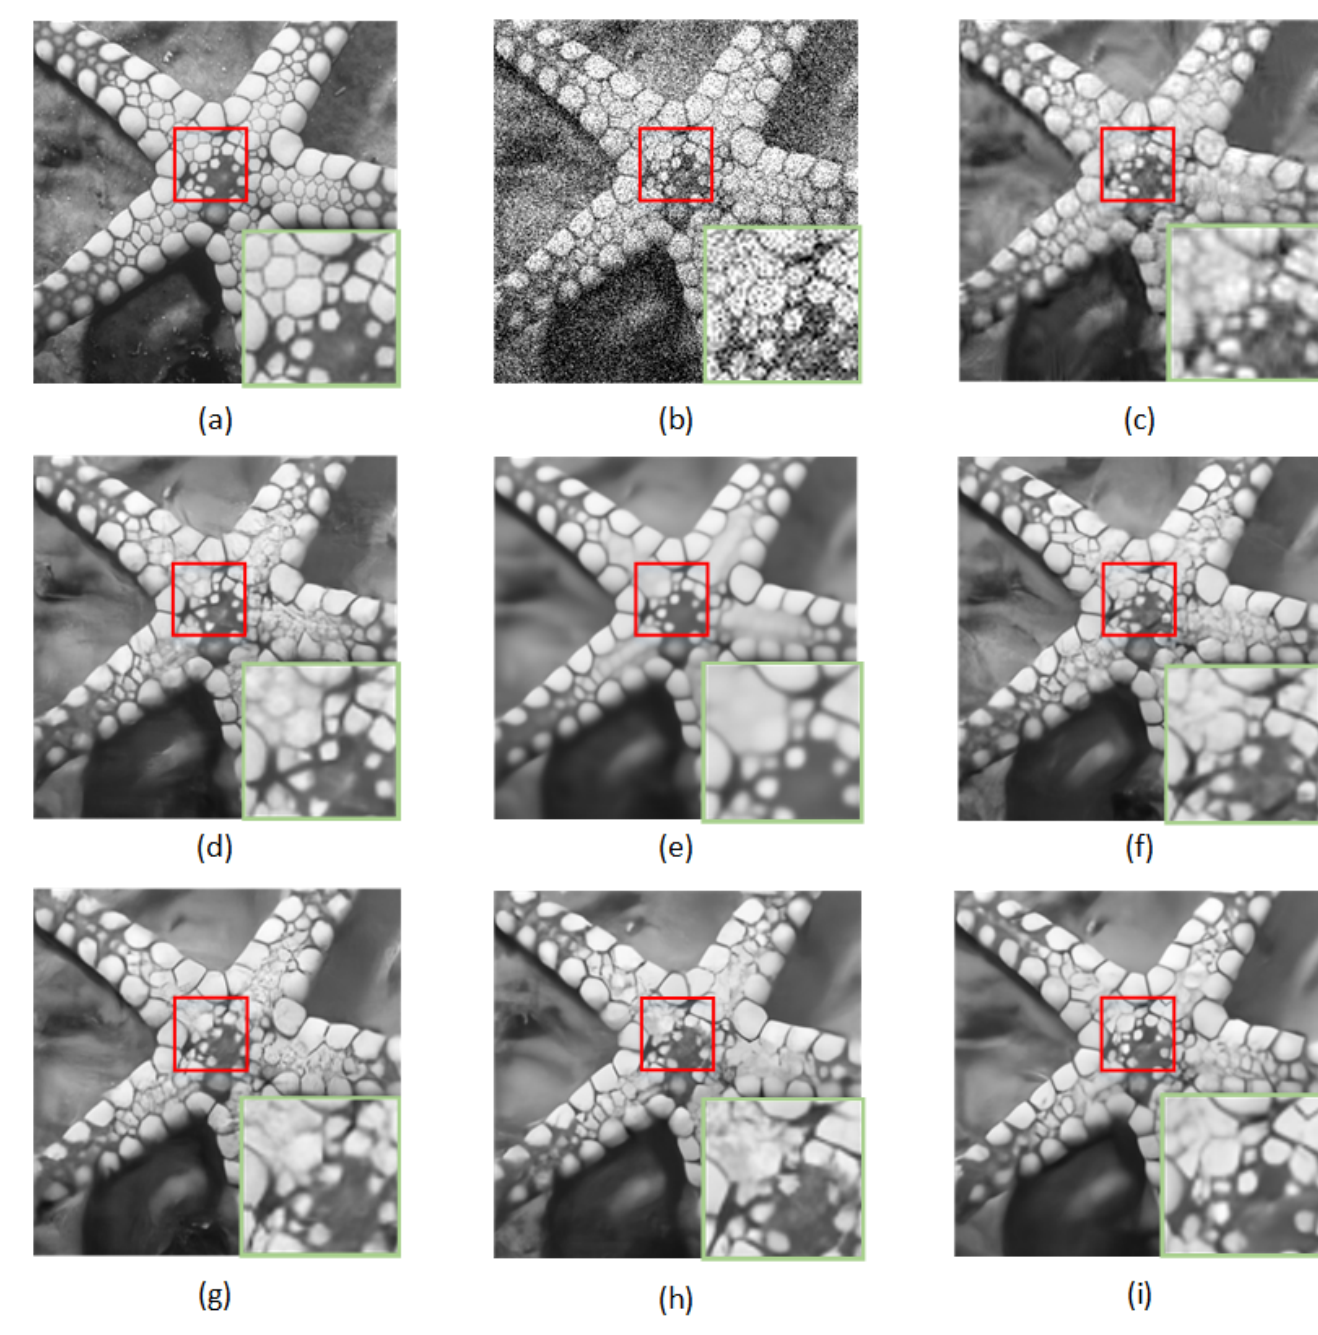
Figure 5. Denoising results of different methods on one image from Set12 with noise level σ =